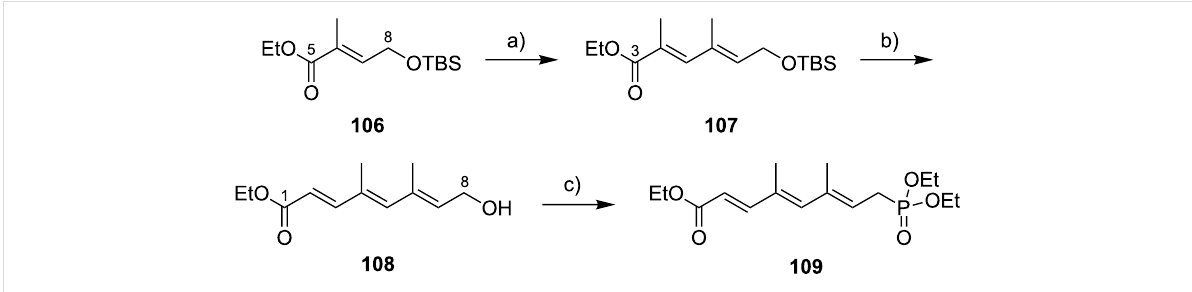
Scheme 12: Gurjar and Cherian’s synthesis of the C1’–C8’ fragment of the mycolactone A/B pentaenoate side chain. Reagents and conditions: a) (i) DIBAL-H, CH 2 Cl 2 , − 78 °C; (ii) MnO 2 , CHCl 3 , rt; (iii) Ph 3 P=C(Me)COOEt, benzene, reflux, 84% (2 steps); b) (i) DIBAL-H, CH 2 Cl 2 , − 78 °C, 92%; (ii) MnO 2 , CHCl 3 , rt; (iii) Ph 3 P=CHCOOEt, benzene, reflux, 83% (2 steps); (iv) TBAF, THF, rt, 93%; c) (i) PBr 3 , Et 2 O, 0 °C; (ii) P(OEt) 3 , 90 °C, 64% (2 steps).